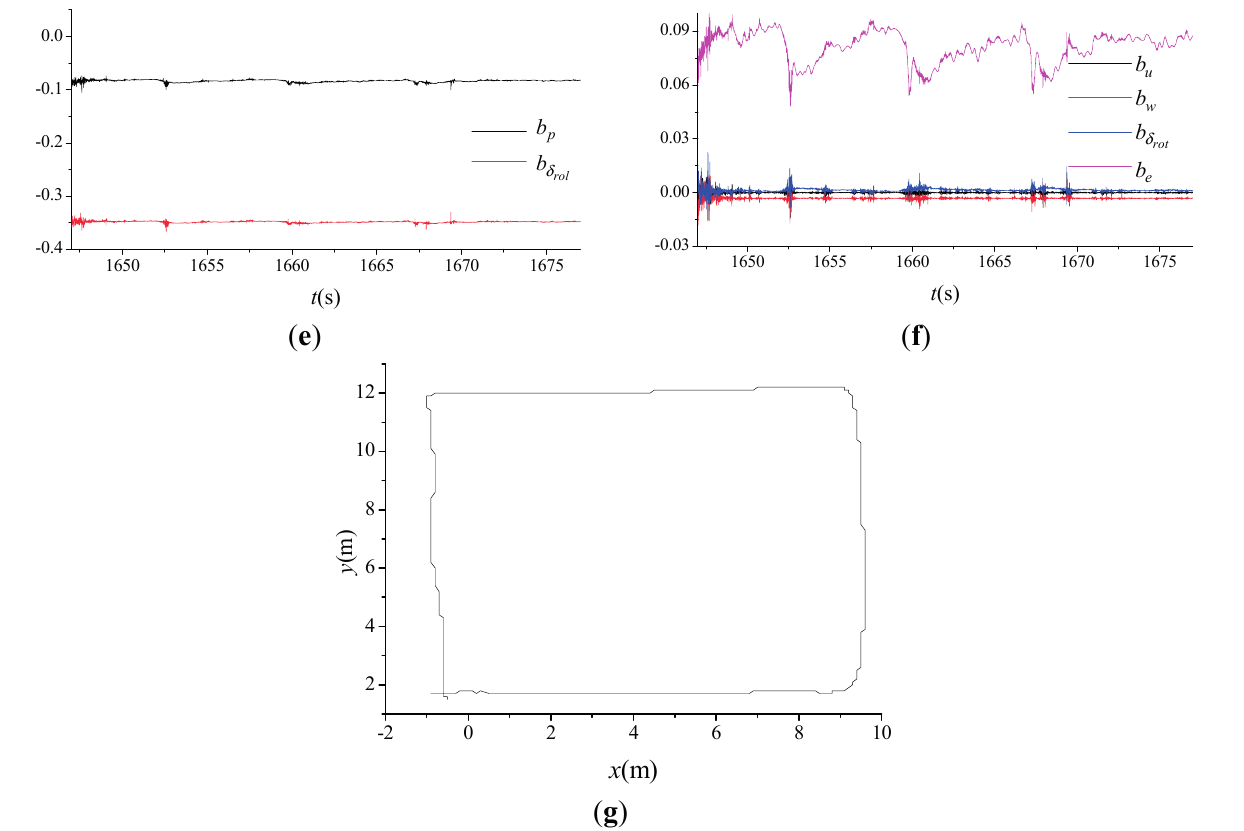
Figure 5. Test results of the proposed strategy. ( a ) θ and φ ; ( b ) ( e ) and ( f ) Identification parameters; ( g ) The ground track view of